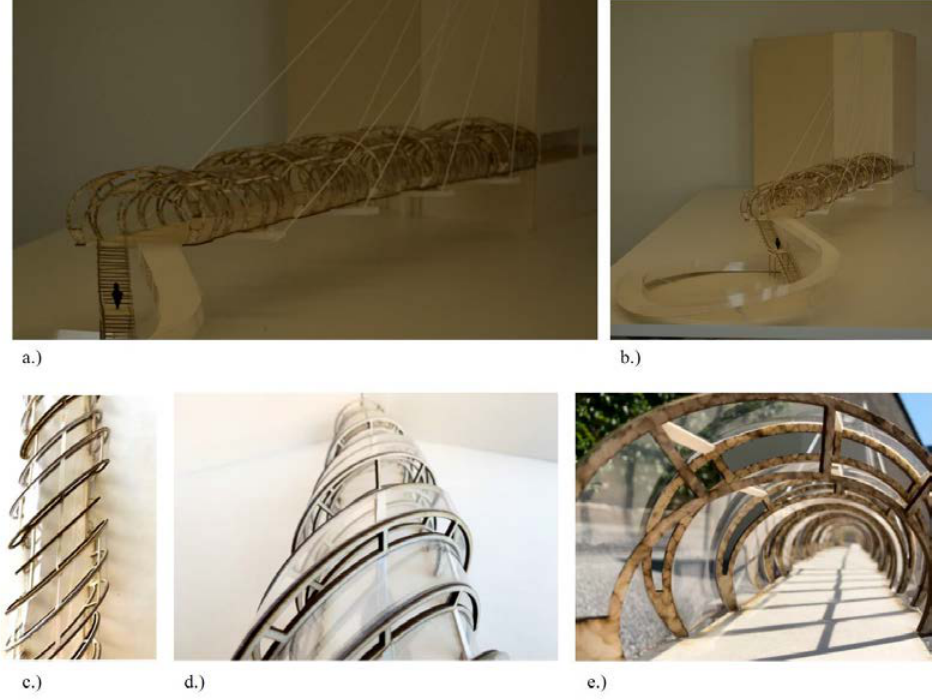
Fig. 12 Final model of the bridge “Wrapping”.